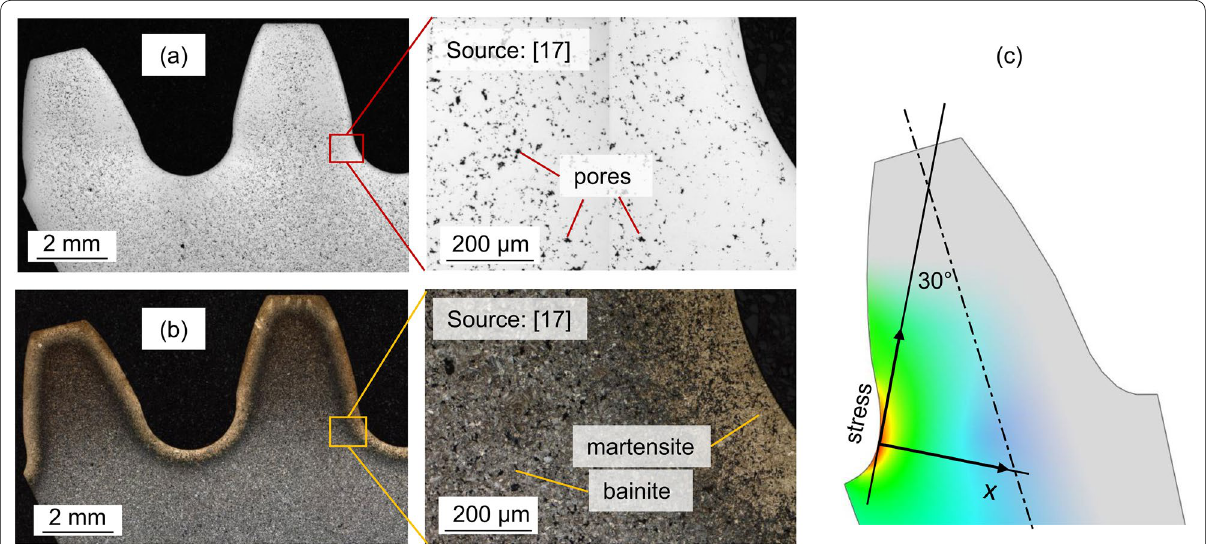
Figure 2 Cross section of a case-hardened sintered gear: a unetched teeth—porosity, b etched teeth—hardened microstructure, c 30°-tangent— high bending